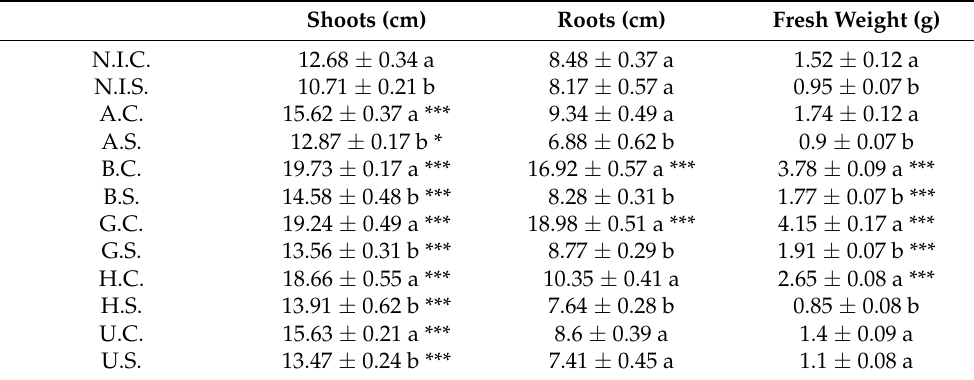
Table 1. Shoot length, roots length, and fresh weight of B. napus cv. SY Saveo grown for 30 days on non-saline soil (C) or saline soil (S). Plants were inoculated with plant growth-promoting bacteria (A = A. brasilense , B = B. ambifaria , G = A. globiformis , H = H. seropedicae , U = Pseudomonas sp. UW4) or not (N.I. = non-inoculated). Different letter means significant difference within the same bacterial treatment. Significant differences between inoculated or non-inoculated plants grown at the same soil condition are marked as * ( p < 0.05), *** ( p < 0.001) ( n = 16).